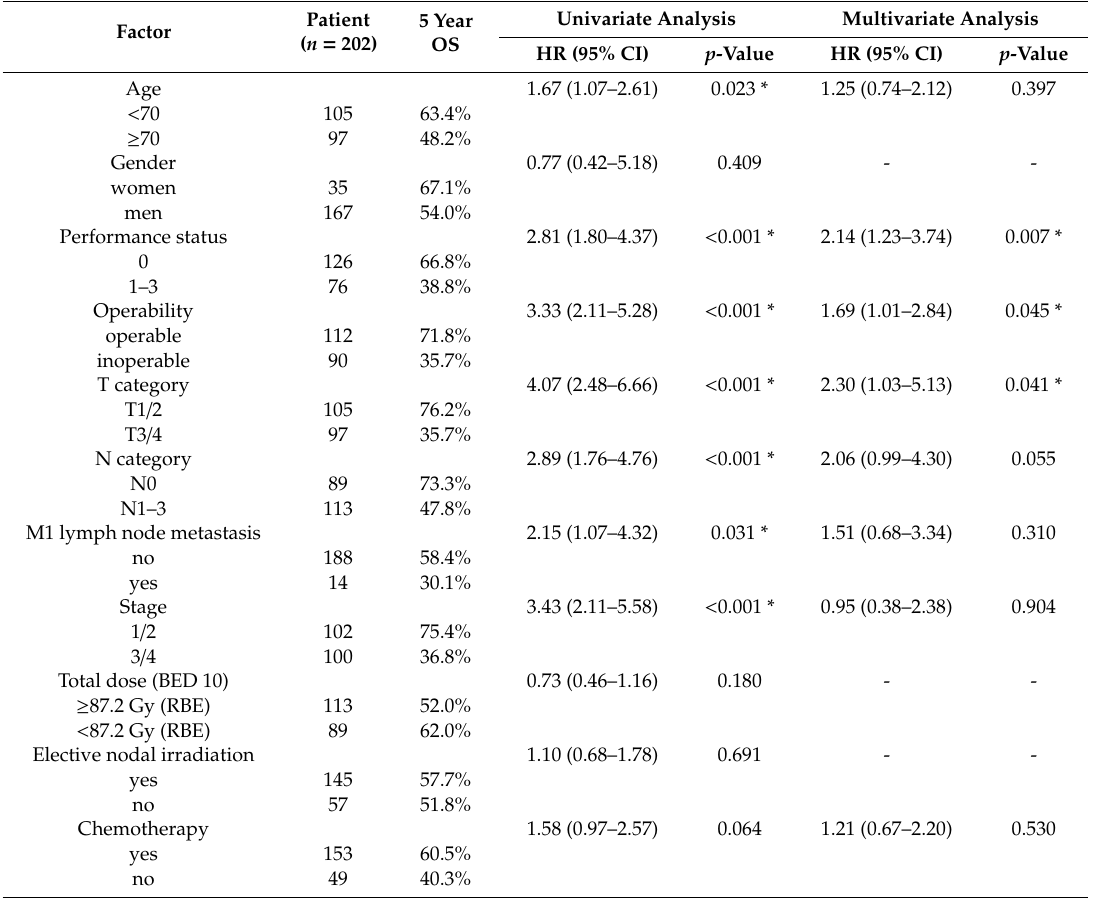
Table 2. Univariate and multivariate analysis for overall